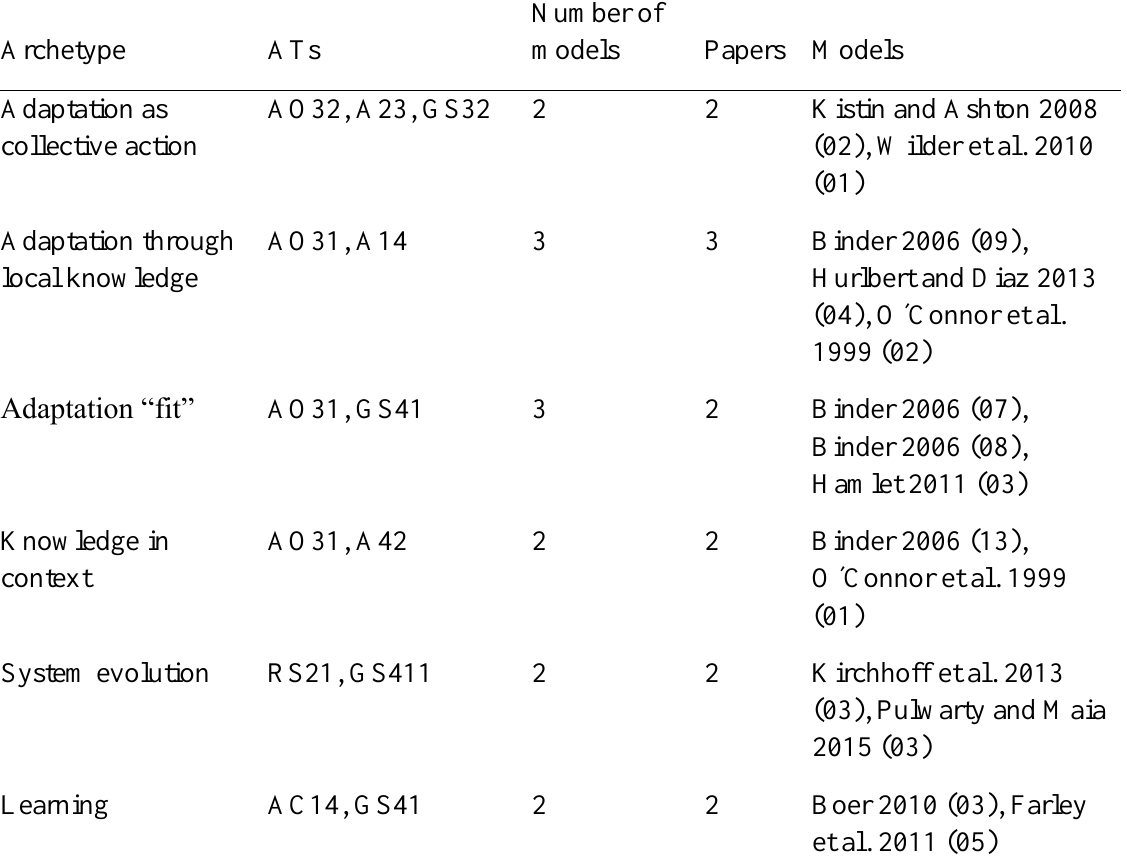
Table A1.3 Archetypes of opportunities for enhancing climate information use. The attributes encompassed thereby are the